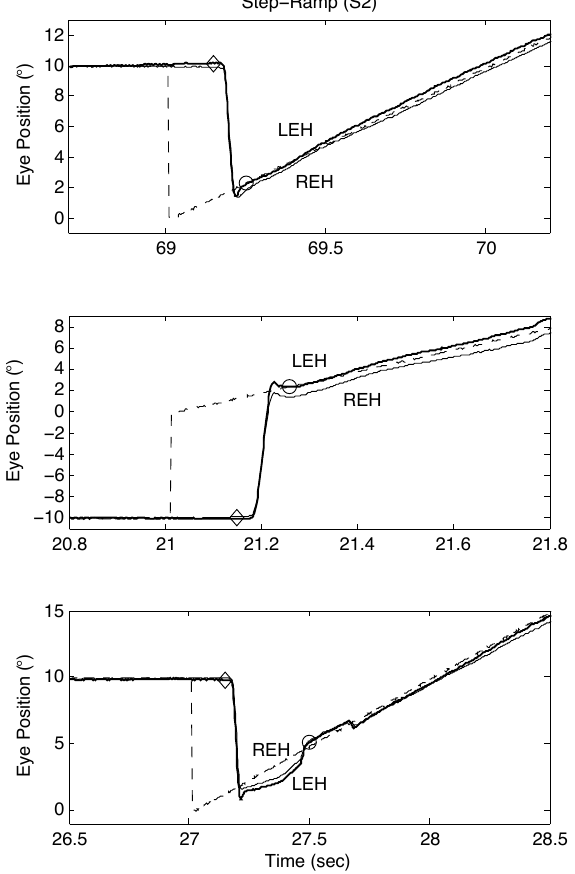
Figure 6. Examples of SR responses from S2 containing proximal saccades demonstrating both classical and other types of response, including those containing disconjugate saccades. See text for descriptions.